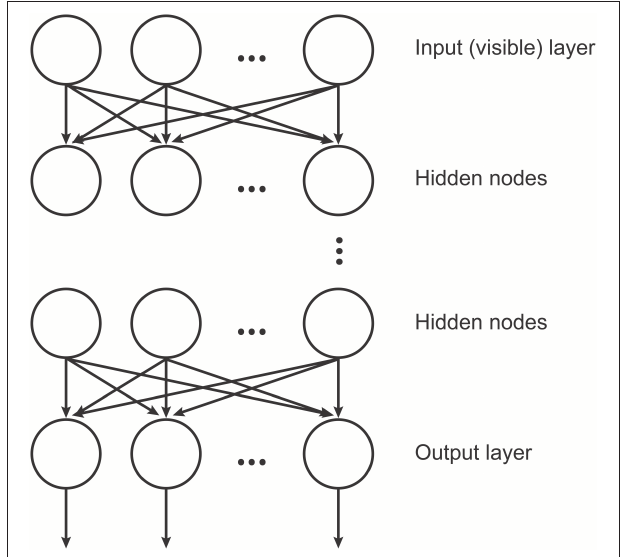
FIGURE 1 | Illustration of the DBN structure, where the hidden layers are RBMs (adapted from Chen et al., 2012).